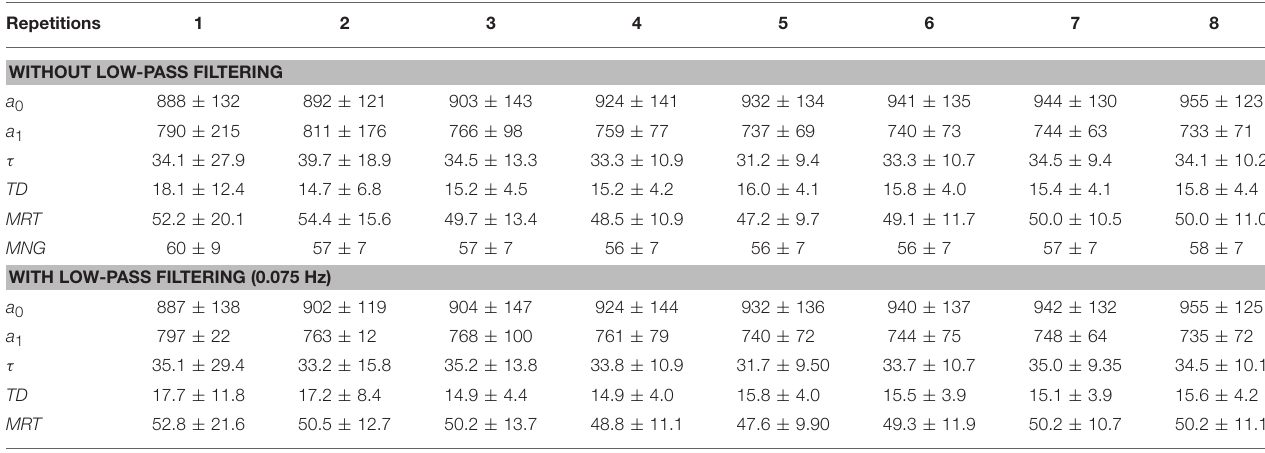
TABLE 3 | Parameter obtained by time-domain oxygen uptake analysis considering different combinations of exercise repetitions (1–8) with our without low-pass filtering (0.075 Hz).